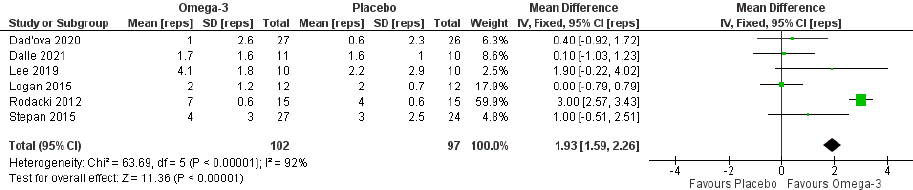
Figure 6. Pooled analysis of the impact of omega-3 supplementation on sit-to-stand performance.